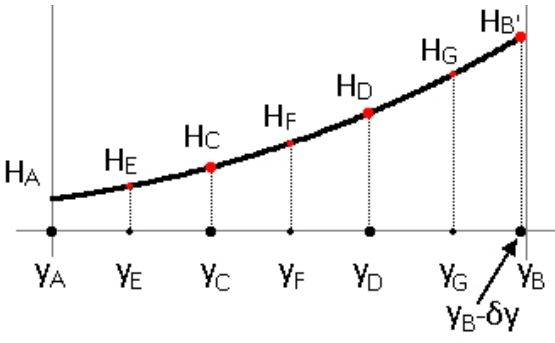
Figure 7 . Specific energy (H) calculated at various elevations (y)